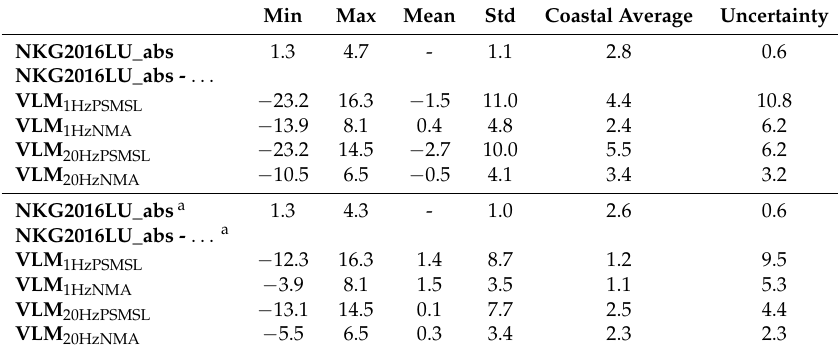
Statistics of NKG2016LU_abs signal as well as statistics of differences between NKG2016LU_abs and VLM rates based on CS2 observations and tide-gauge data along the Norwegian coast in mm/year. The upper part of the table shows the statistics over all 20 tide gauges, while the lower part shows the statistics excluding Trondheim, Heimsjø, and Oscarsborg. The last two columns represent the coastal averages and uncertainties (defined in Equation (1) for estimated VLM rates and adopted from Olsson et al. [28] for NKG2016LU_abs) calculated over tide gauges.